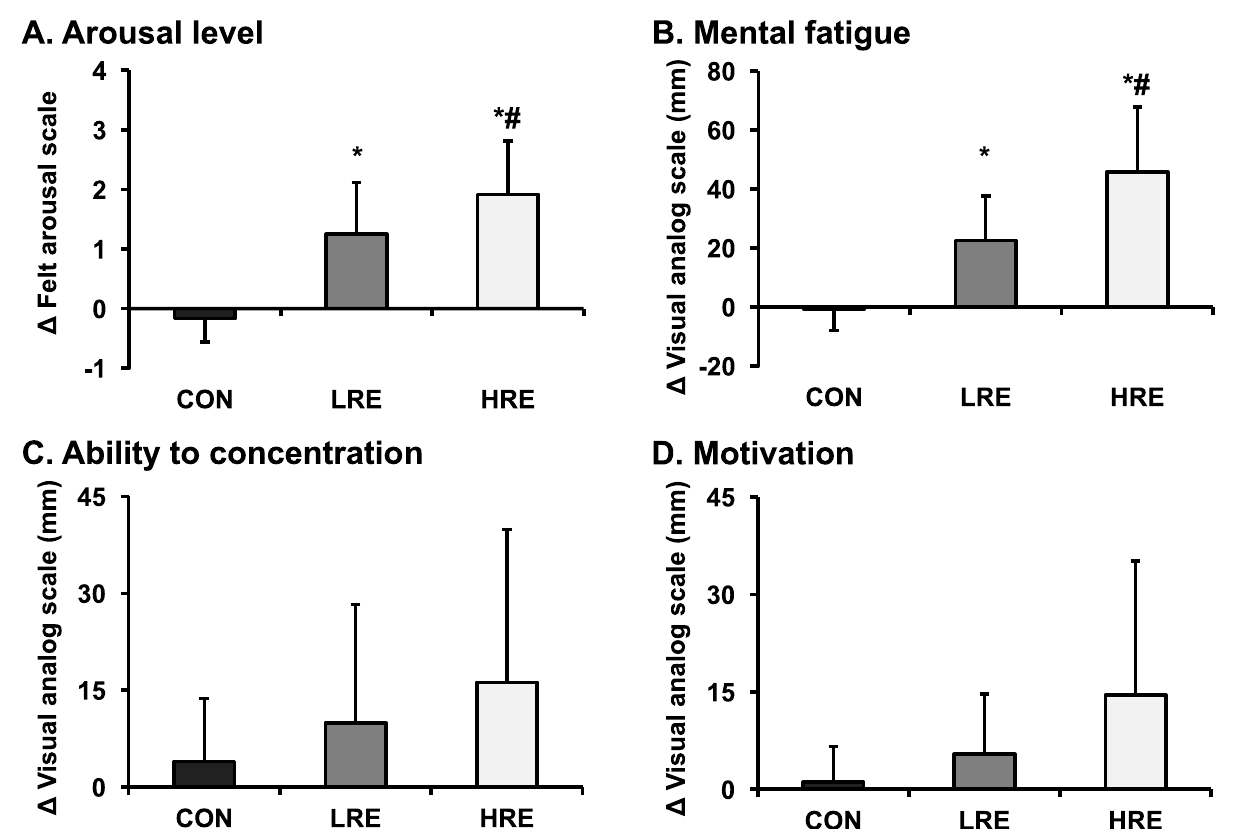
Fig 3. Changes in psychological parameters for CWST. The panelsillustrate the changesin arousallevel (A), mental fatigue (B), ability to concentrate(C), and motivation(D) in the pre- and post-CWST periods amongall conditions. The arousal level was evaluatedby felt arousalscale. Mental fatigue, ability to concentrate, and motivation was evaluatedby visual analogscale. The values are shown as the mean ± SD. * vs. CON P < 0.05, # vs. LRE P < 0.05.